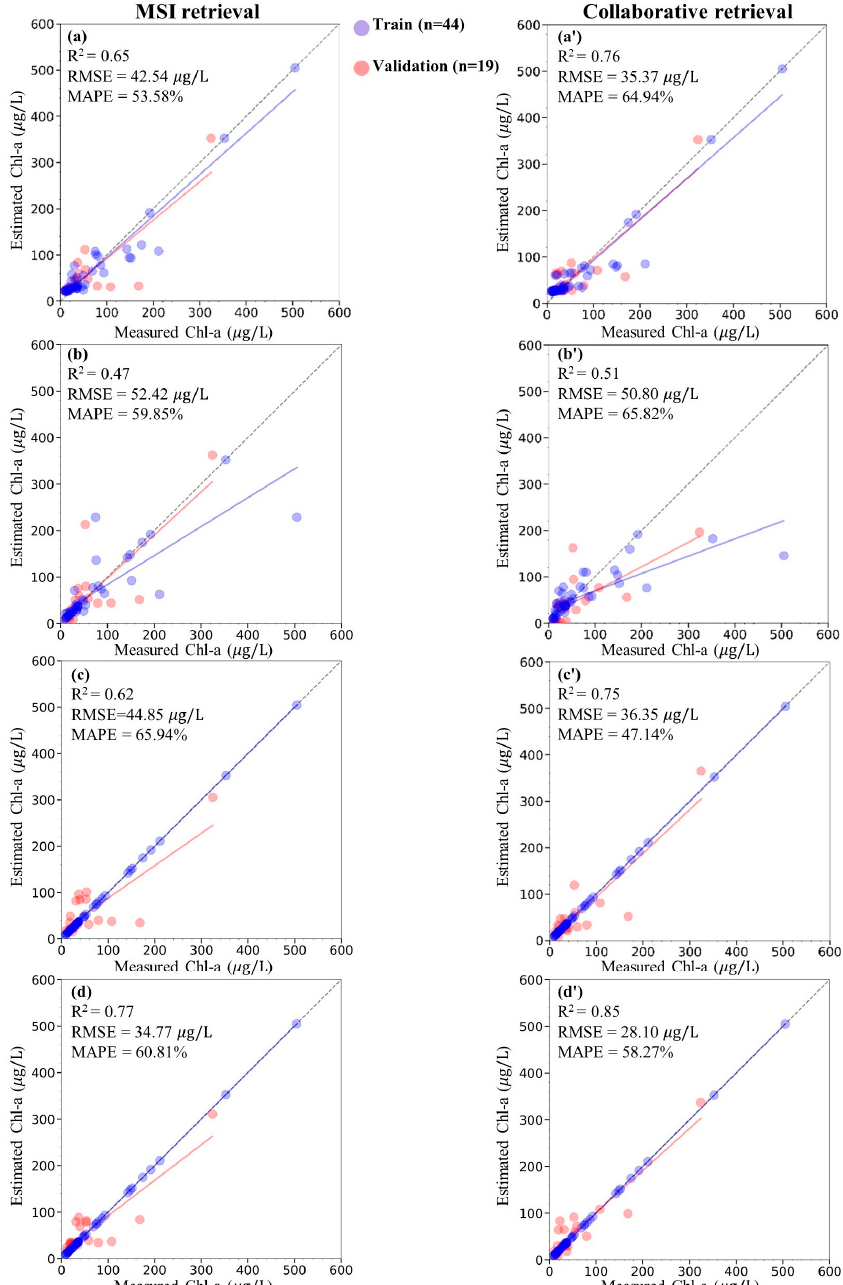
Figure 9. Statistical metrics of Chl-a retrieval using four machine learning models for MSI and collaborative retrieval. ( a , a ' ) Adaboost model; ( b , b ' ) SVR model; ( c , c ' ) XGboost model; ( d , d ' ) GBDT model.